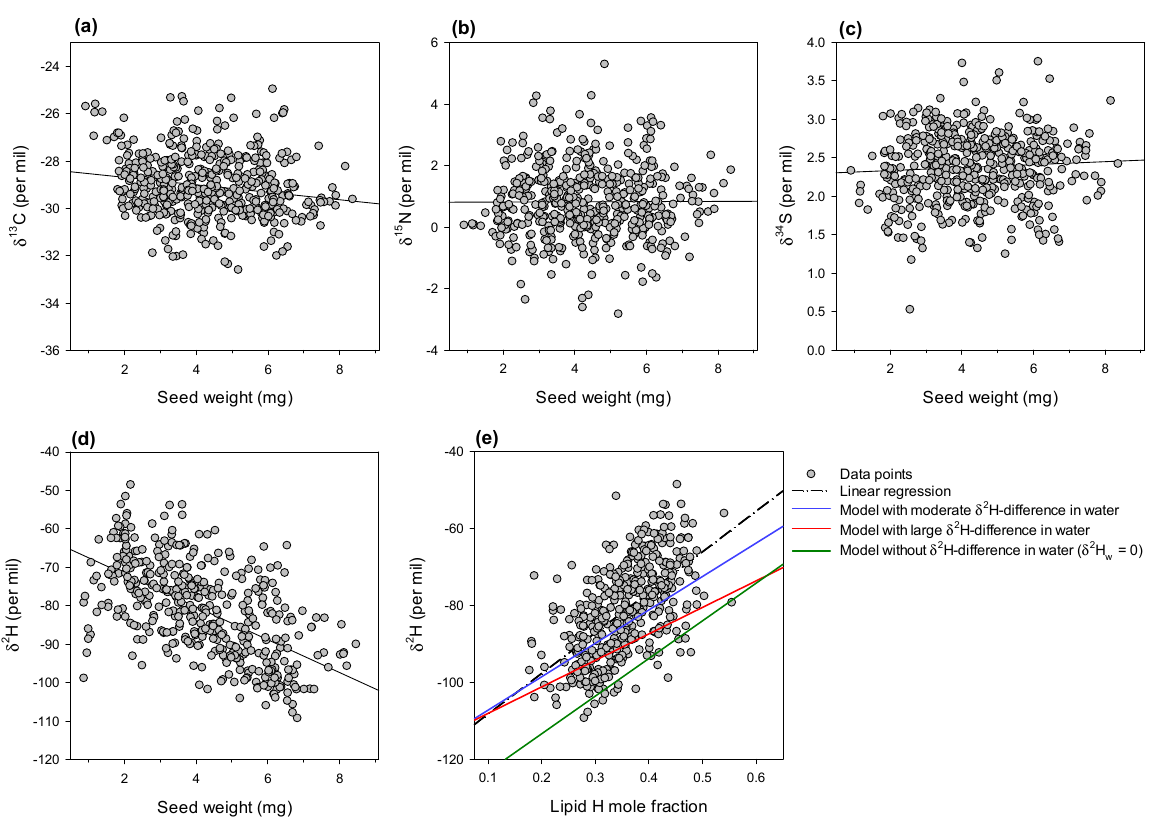
Figure 2. Seed isotope composition (previous page). Natural abundance in 13 C ( a ), 15 N ( b ), 34 S ( c ) and deuterium ( 2 H) ( d ) in seeds, plotted against seed weight. Black lines stand for linear regressions (insignificant for 13 C, 15 N and 34 S; significant for 2 H, R 2 = 0.33, p < 0.0001). ( e ) Relationship between hydrogen isotope composition and hydrogen mole fraction represented by lipids in seeds. The dash-dotted black line stands for the linear regression ( R 2 = 0.38, p < 0.0001), while the coloured solid lines represent the predicted δ 2 H using isotopic mass–balance models.